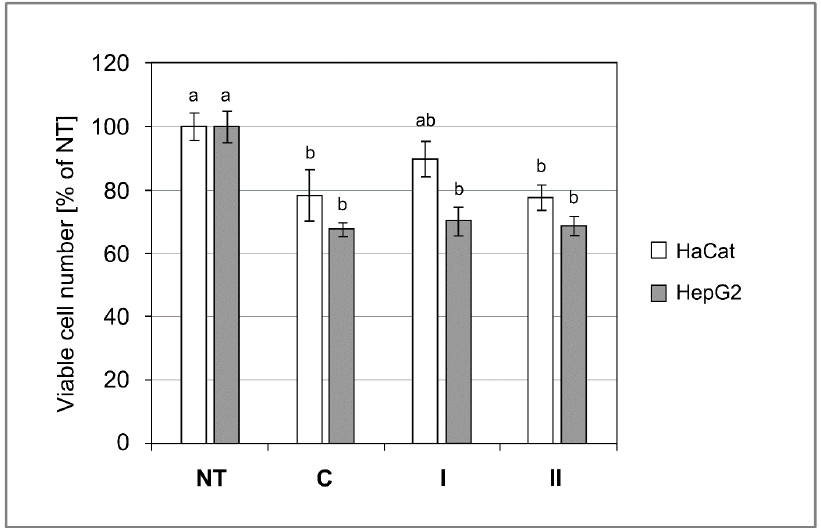
Figure 7. Graphene additive to starch/chitosan composites do not increase cytotoxicity. The bars represent mean ± SEM ( n = 8) of cell numbers expressed as percentage of non-treated control (NT). C—control composite; I—nanocomposite I.; II —nanocomposite II. The bars with the same letters (a, b) do not differ significantly at the level of confidence 0.05.